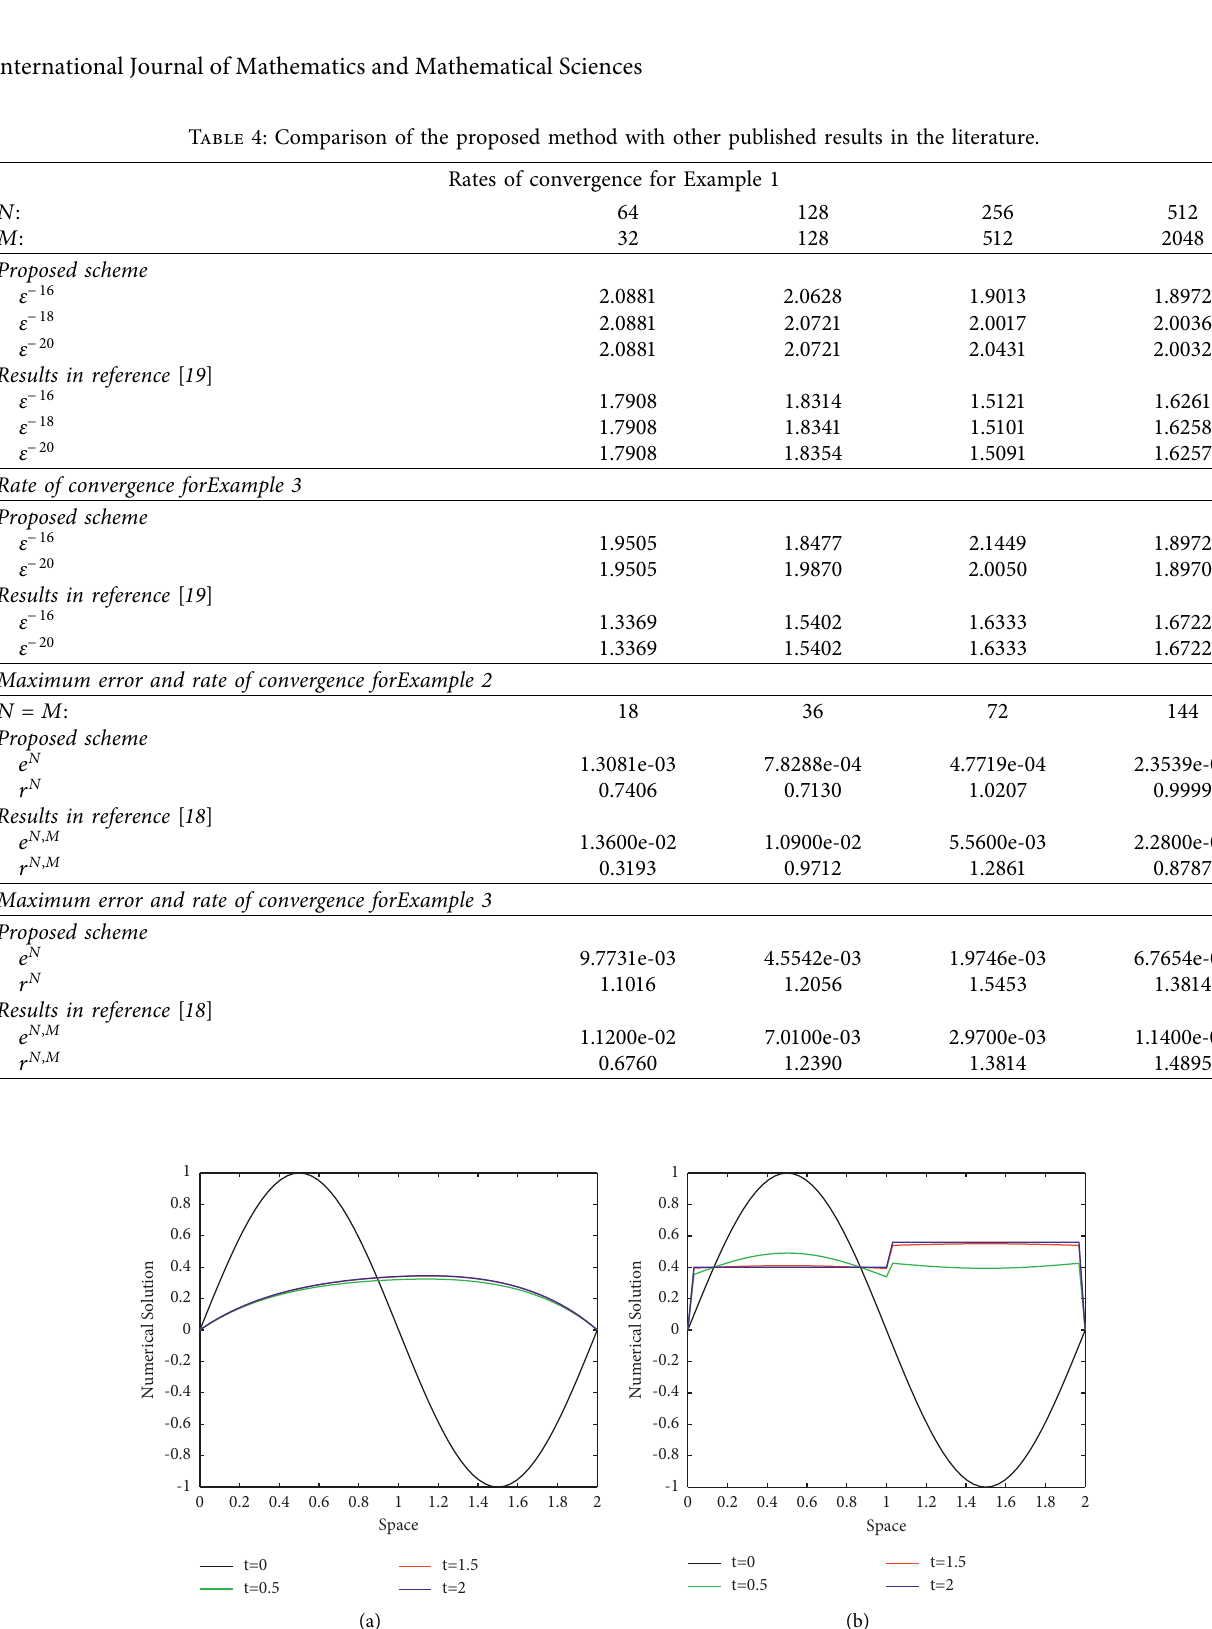
Figure 1: Line plots for the numerical solution of Example 1 for N � 128 and M � 64 at diferent time levels. (a) [ ε � 2 0 ], (b) [ ε � 2 − 16